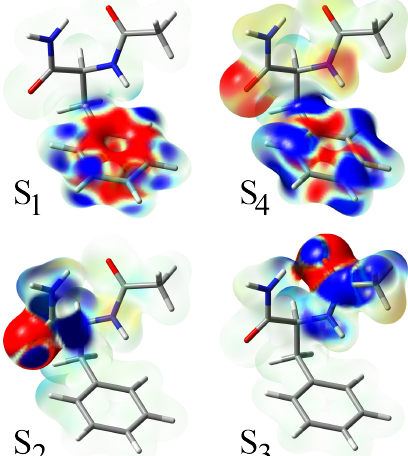
Figure 4. Charge migration in NAPA conformer B upon vertical excitation. CC2 electron density differences between the excited and ground electronic states mapped on the ground state total density isosurface of 0.02 Å − 3 . The red (blue) areas indicate depletion (increase) of electron density in the excited state with respect to the ground state. Upper panel S 1 ( ππ ∗ ) and S 4 ( ππ ∗ ) ; lower panel ) and S ( n π ∗ ) S 2 ( n π ∗ 3 ( II ) ( I )